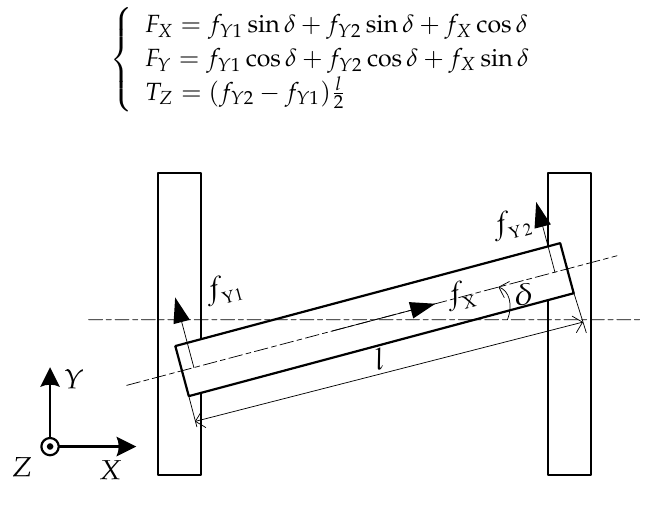
Figure 2. H-shaped platform force Figure 2. H ‐ shaped platform force analysis.